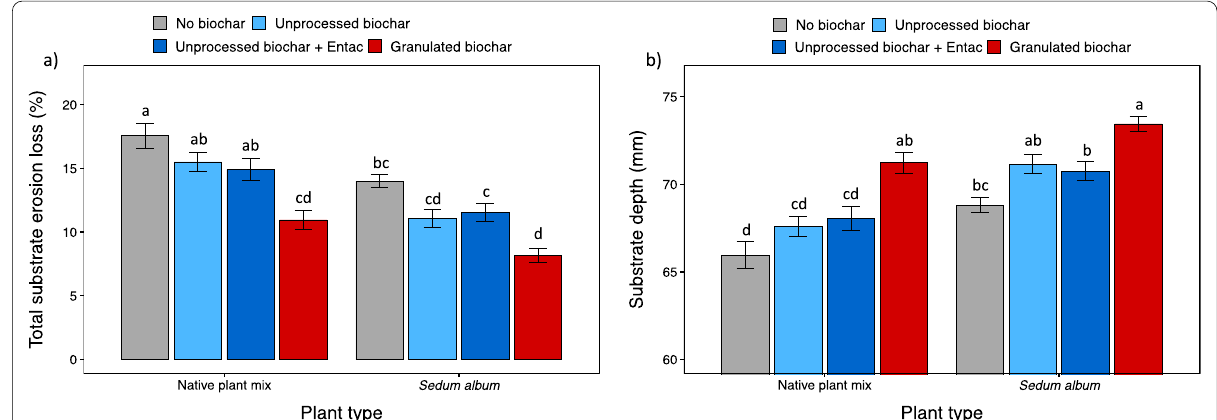
Fig. 2 Total substrate erosion loss ( a ) and substrate depth ( b ) on green roof modules by treatment. Bars plot mean values (n 7 replicates per treatment). Bars with different lowercase letters within each figure differ significantly at P < 0.05 according to Tukey’s HSD test = following two-way ANOVA